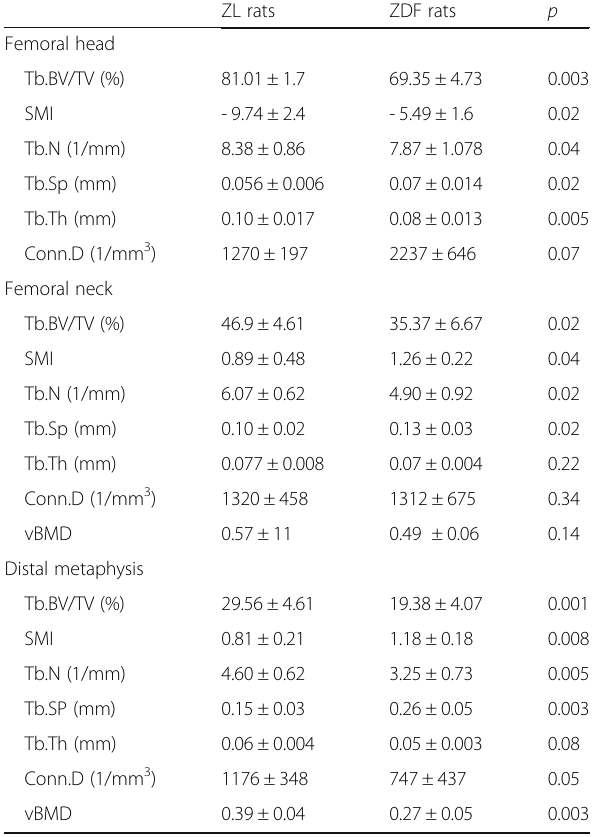
Table 1 Analysis of trabecular bone ZL rats ZDF